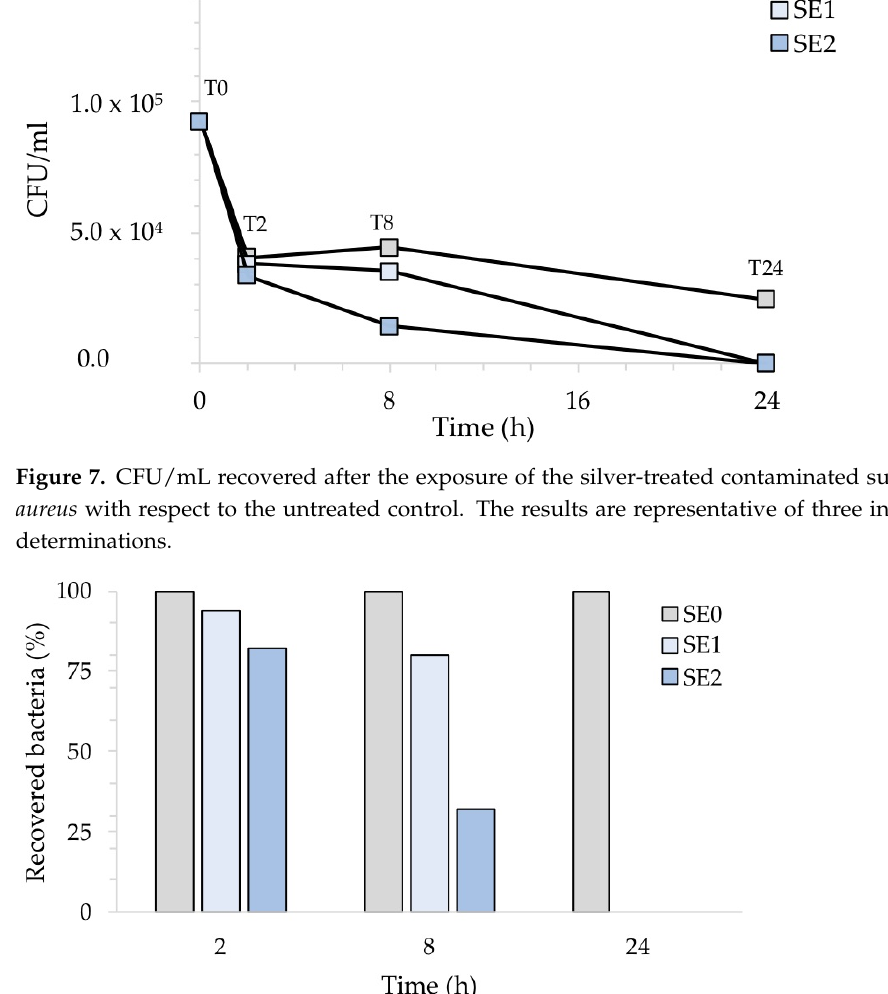
Int. J. Mol. Sci. 2023 , 24 , x FOR PEER REVIEW